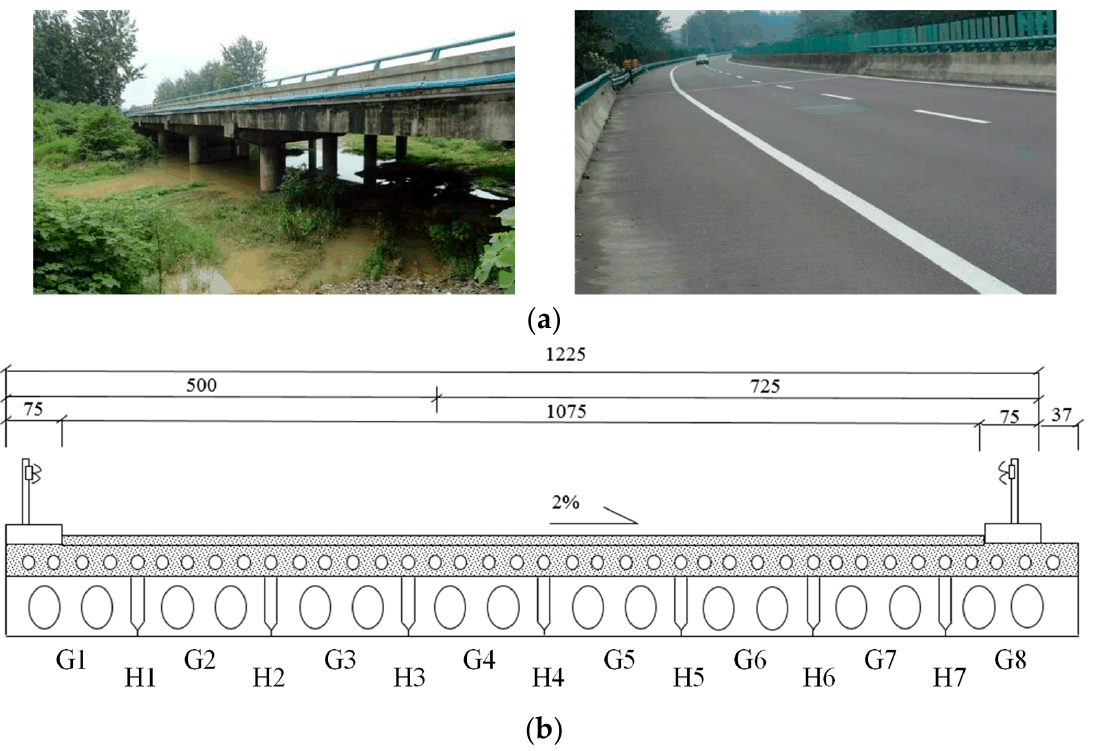
Figure 1. Hollow slab bridge in Wu-He highway system: ( a ) an overview; ( b ) cross-section.